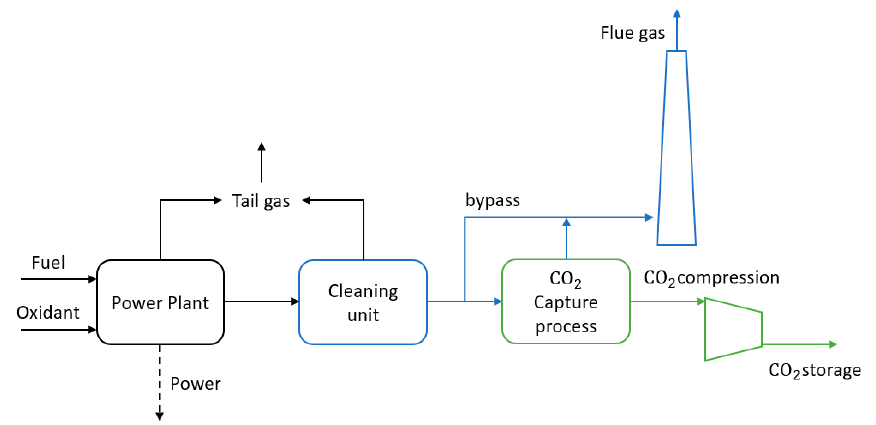
Figure 5 . Block flow diagram of power plant with post-combustion CO 2 capture technology.